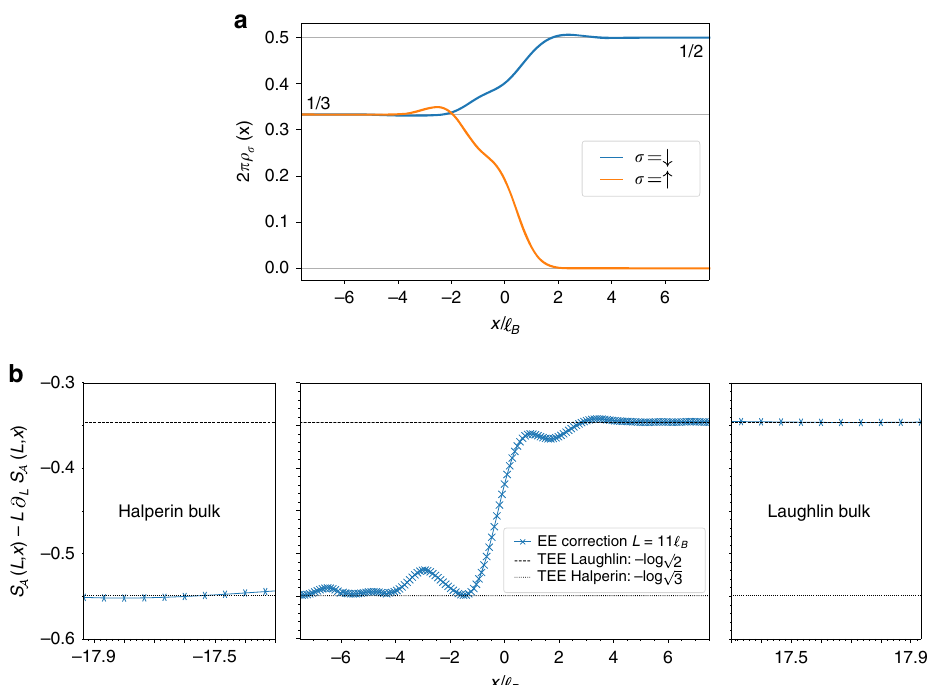
Fig. 2 An interface between two toplogical orders: a Spin resolved densities of the MPS ansatz state along the cylinder axis. They smoothly interpolate between the Laughlin (2 πρ ↓ = 1/2 and ρ ↑ = 0) and the Halperin (2 πρ ↓ = 2 πρ ↑ = 1/3) theoretical values. The persistent density inhomogeneity is an edge reconstruction due to interactions (see Eq. (1)). b Constant correction of the EE to the area law for a rotationally symmetric bipartition at position x . The correction is found to be constant (see Eq. (3)). The extraction of the TEE deep in the Laughlin and Halperin bulks shows that the MPS ansatz correctly captures the topological properties away from the